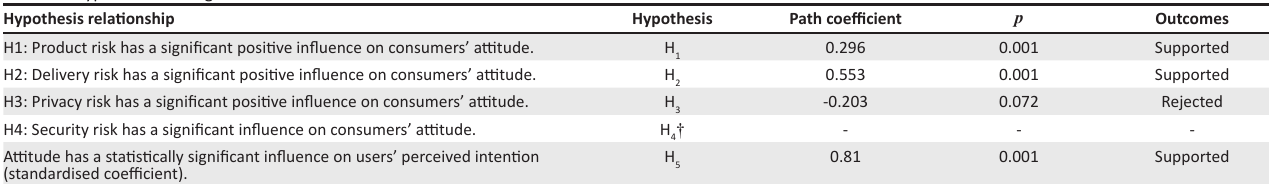
TABLE 6: Hypothesis testing